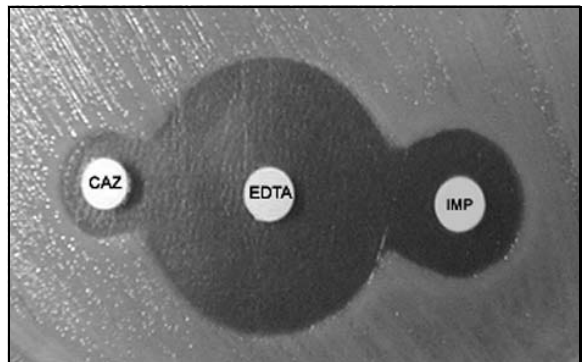
Figura 5 – Amostra clínica apresentando teste fenotípico negativo para a produção de MßL. O teste não evidencia alteração no halo de inibição do crescimento da